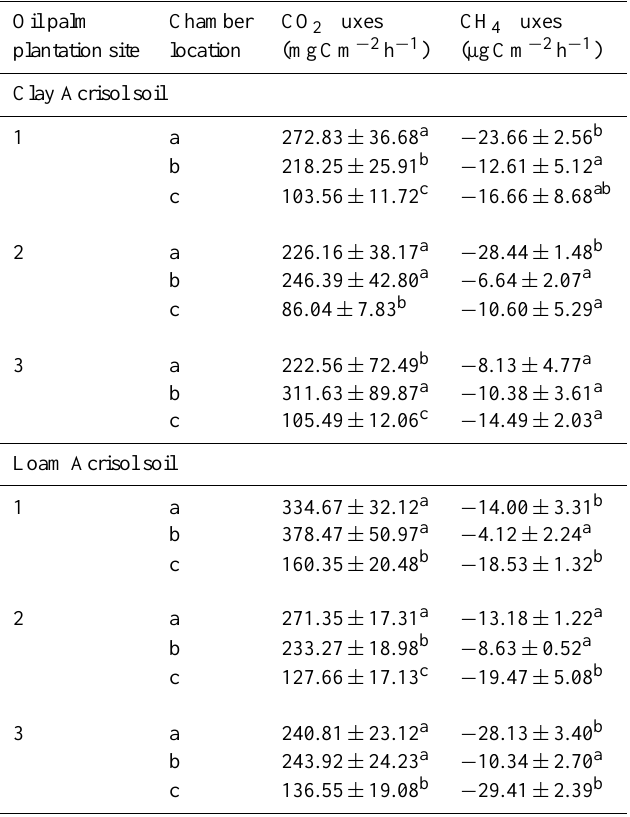
Table A3. Mean ( ± SE, n = 3 oil palm trees) soil CO 2 and CH 4 fluxes from three different chamber locations during a fertilization in three oil palm plantations within each soil landscape, measured 6 to 11 times during 3–8.5 weeks following fertilization. Means followed by different letters indicate significant differences among chamber locations within each oil palm plantation site (linear mixed-effect models with Fisher’s LSD test at P ≤ 0 . 05). Chamber locations a, b and c were placed at 0.3, 0.8, and 4–4.5m, respectively, from each of the three trees at each oil palm plantation site. Smallholders fertilized the area around the base of each tree about 0.8–1m from the tree base, and thus chamber location b was on this fertilized area and chamber location c serves as the reference chamber not receiving any fertilizer. The same fertilization rate and form as applied by the smallholders were used in these studied oil palm plantations, described in Sect. 2.2 “CO 2 and CH 4 flux